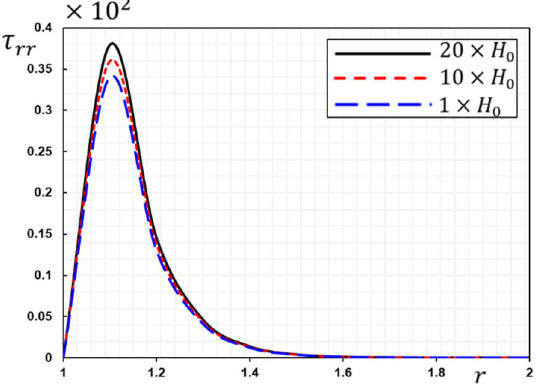
Figure 8. The radial Maxwell stress, τ rr , versus the axial magnetic field, H 0